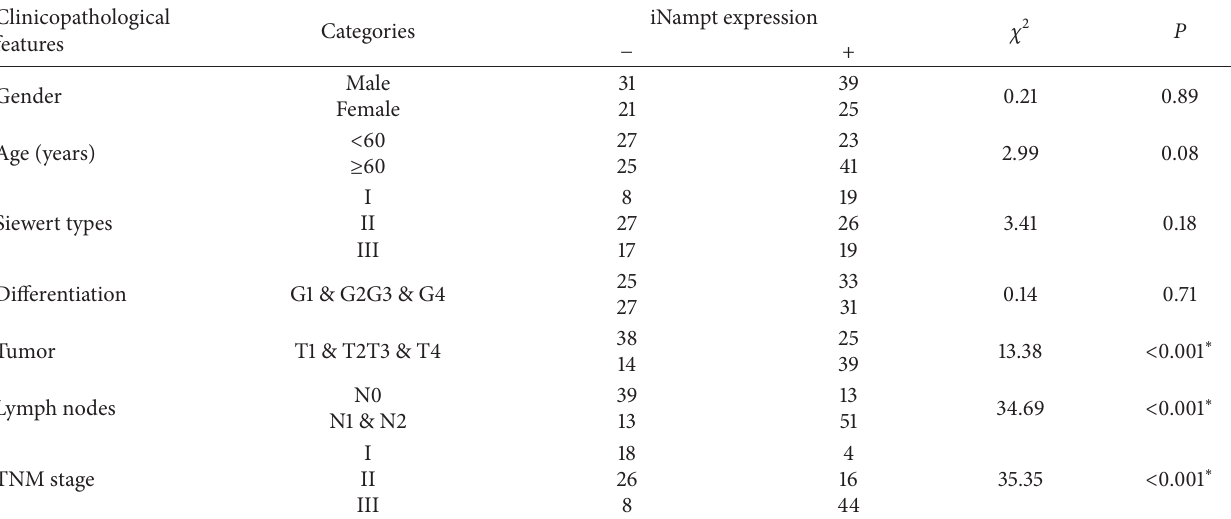
Table 1: Clinical correlation of iNampt protein expression in EGA.